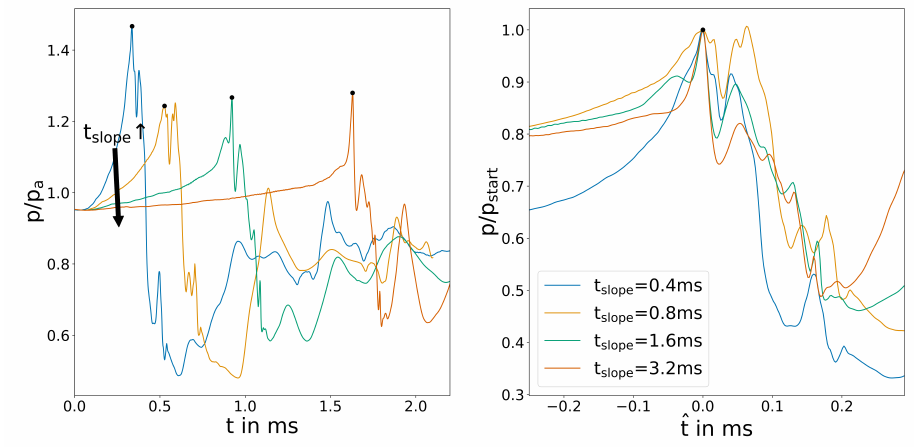
Figure 7. Averaged outlet channel pressure for the variation of t slope